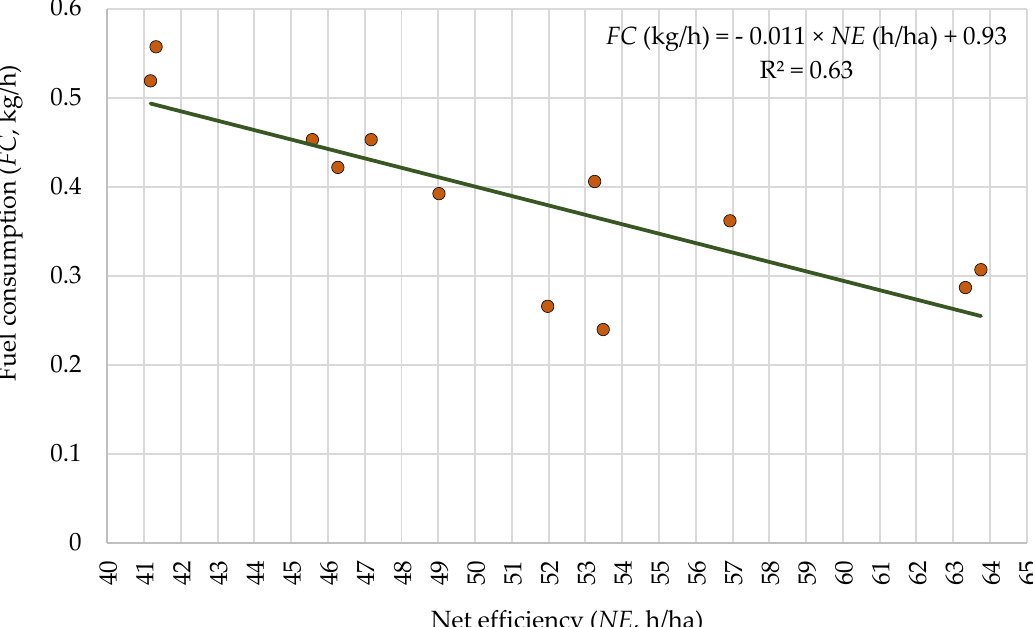
Figure 3. Dependence relation between the fuel consumption ( FC, kg/h) and net efficiency rate ( NE , h/ha).